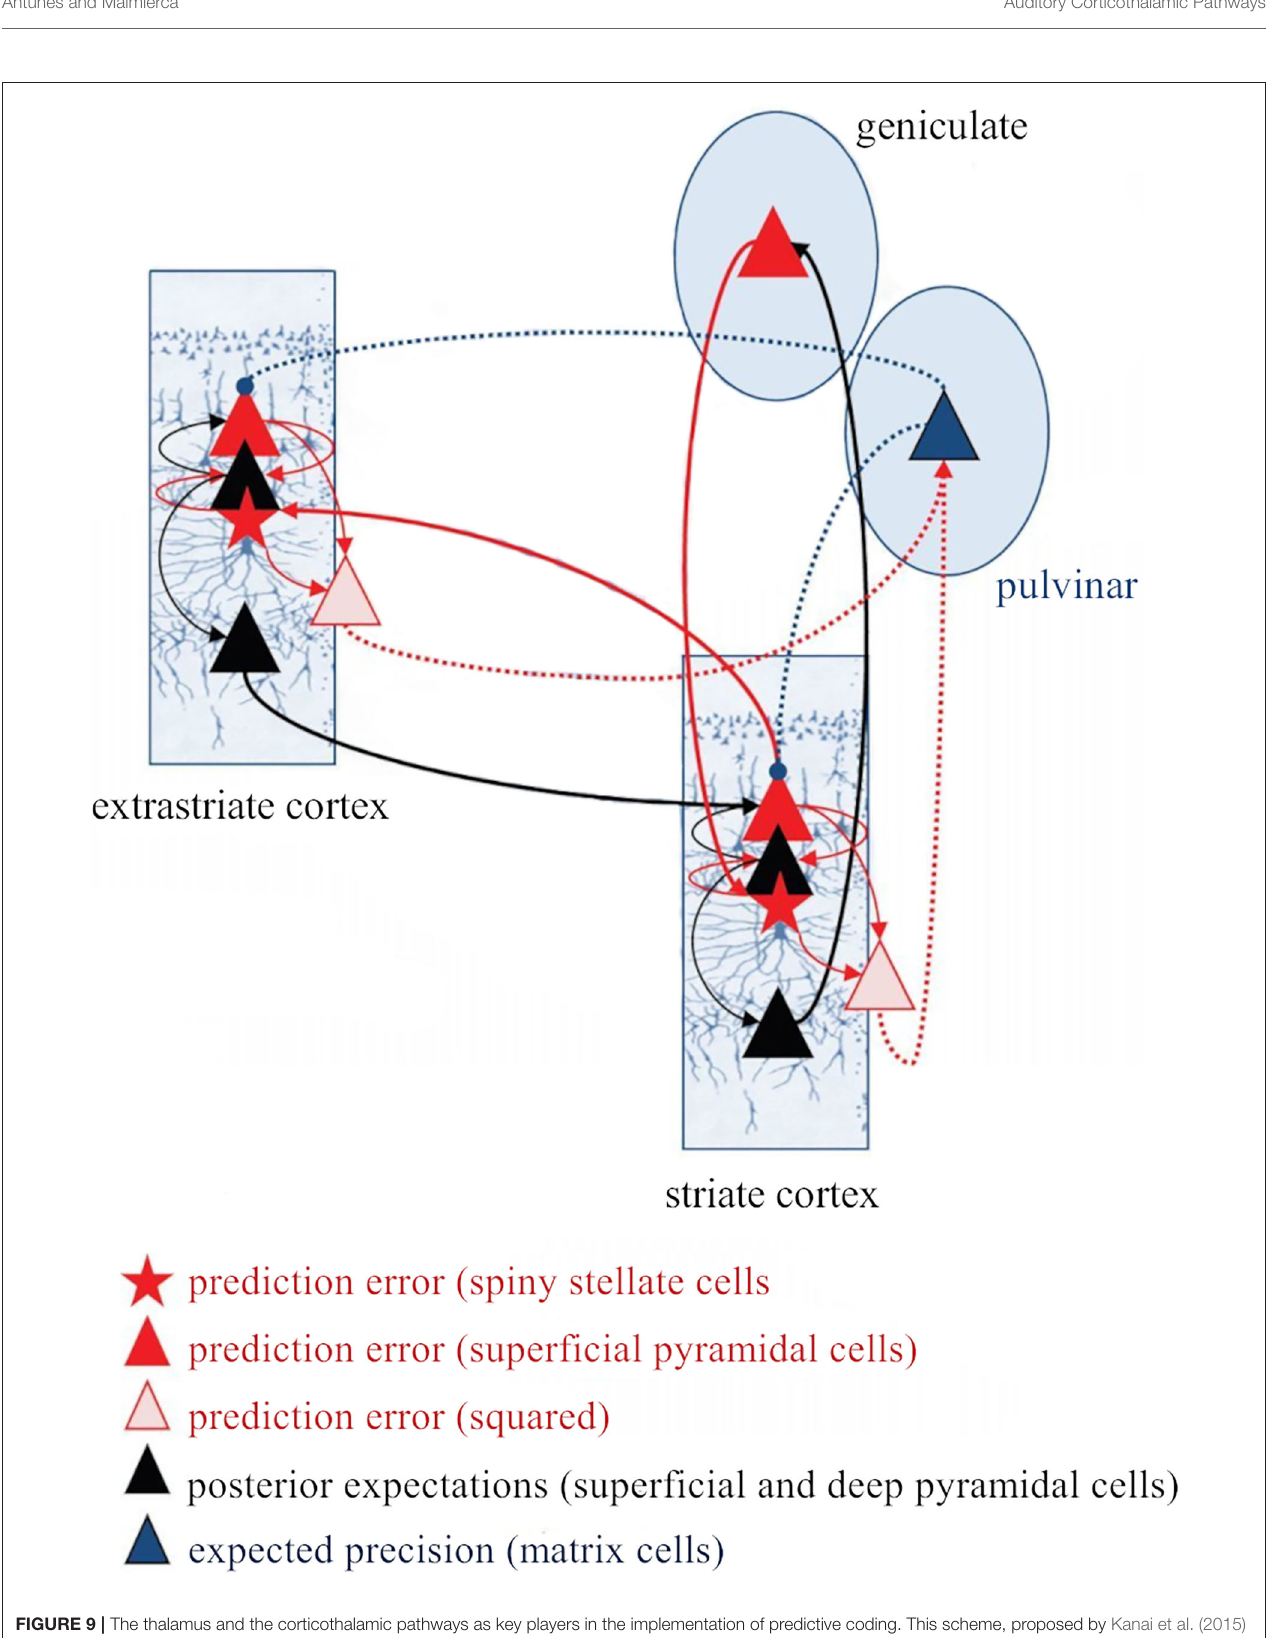
FIGURE 9 | The thalamus and the corticothalamic pathways as key players in the implementation of predictive coding. This scheme, proposed by Kanai et al. (2015) expands the classical implementation of predictive coding [Bastos et al. (2012), Shipp (2016)] as Figure 7 shows, because it incorporates the thalamus and the